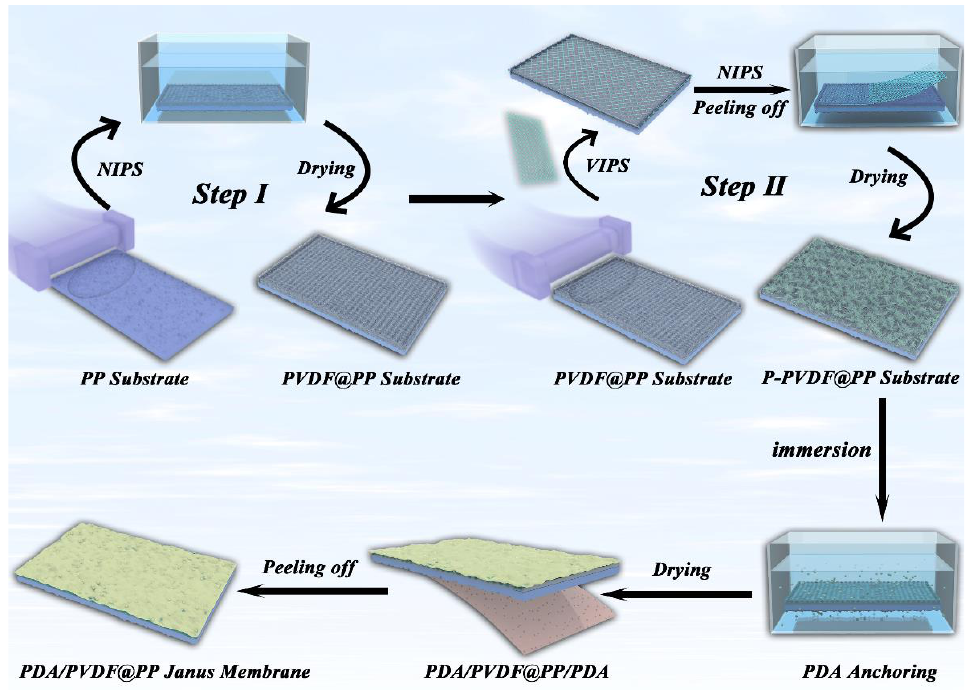
Figure 1. The construction process of the as-designed PDA/P-PVDF@PP Janus membrane.